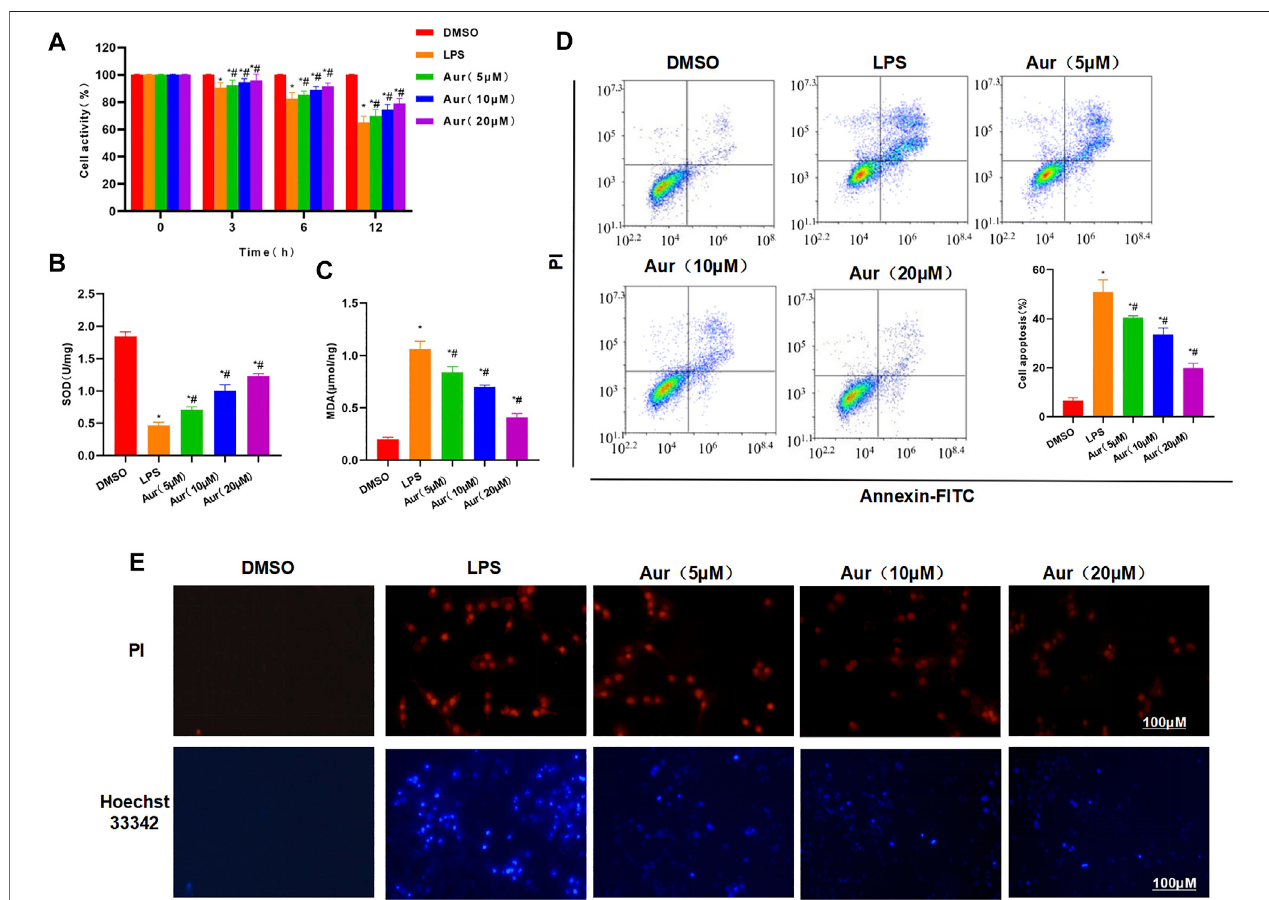
FIGURE1| Effect ofAuron LPS-induced KCinjury. (A) Effect ofAuroncell viability(n (cid:1) 3). The cellviabilityintheLPS group wassigni fi cantlymore decreasedthan theDMSOgroup;whileAurtreatment couldsuppress thedecrease inviability,whichwassigni fi cantlydifferentfromtheLPSgroup.Inaddition, thepairwisecomparison was also statistically signi fi cant. Comparison with DMSO, * p < 0.05; comparison with LPS group, # p < 0.05. (B,C) Effect of Aur on SOD and MDA (n (cid:1) 3). The SOD level was downregulated and the MDA level was upregulated in the LPS group, which were signi fi cantly different from the DMSO group. Aur treatment could decrease theMDAlevelandincreasetheSODlevelinadose-dependentpattern. ComparisonwithDMSO,* p < 0.05;comparisonwithLPSgroup, # p < 0.05. (D) Apoptosisassay (n (cid:1) 3).TheapoptoticlevelwaslowintheDMSOgroup,LPScouldsigni fi cantlyincreasetheapoptoticlevel,andAurcoulddownregulatetheapoptoticlevel.Comparison with DMSO, * p < 0.05; comparison with LPS group, # p < 0.05. (E) PI staining and Hoechst 33342 staining (n (cid:1) 3). Positive cells were barely detectable in the DMSO group, which were signi fi cantly upregulated in the LPS group. While the number of positive cells was downregulated in the Aur group, indicating the suppressed